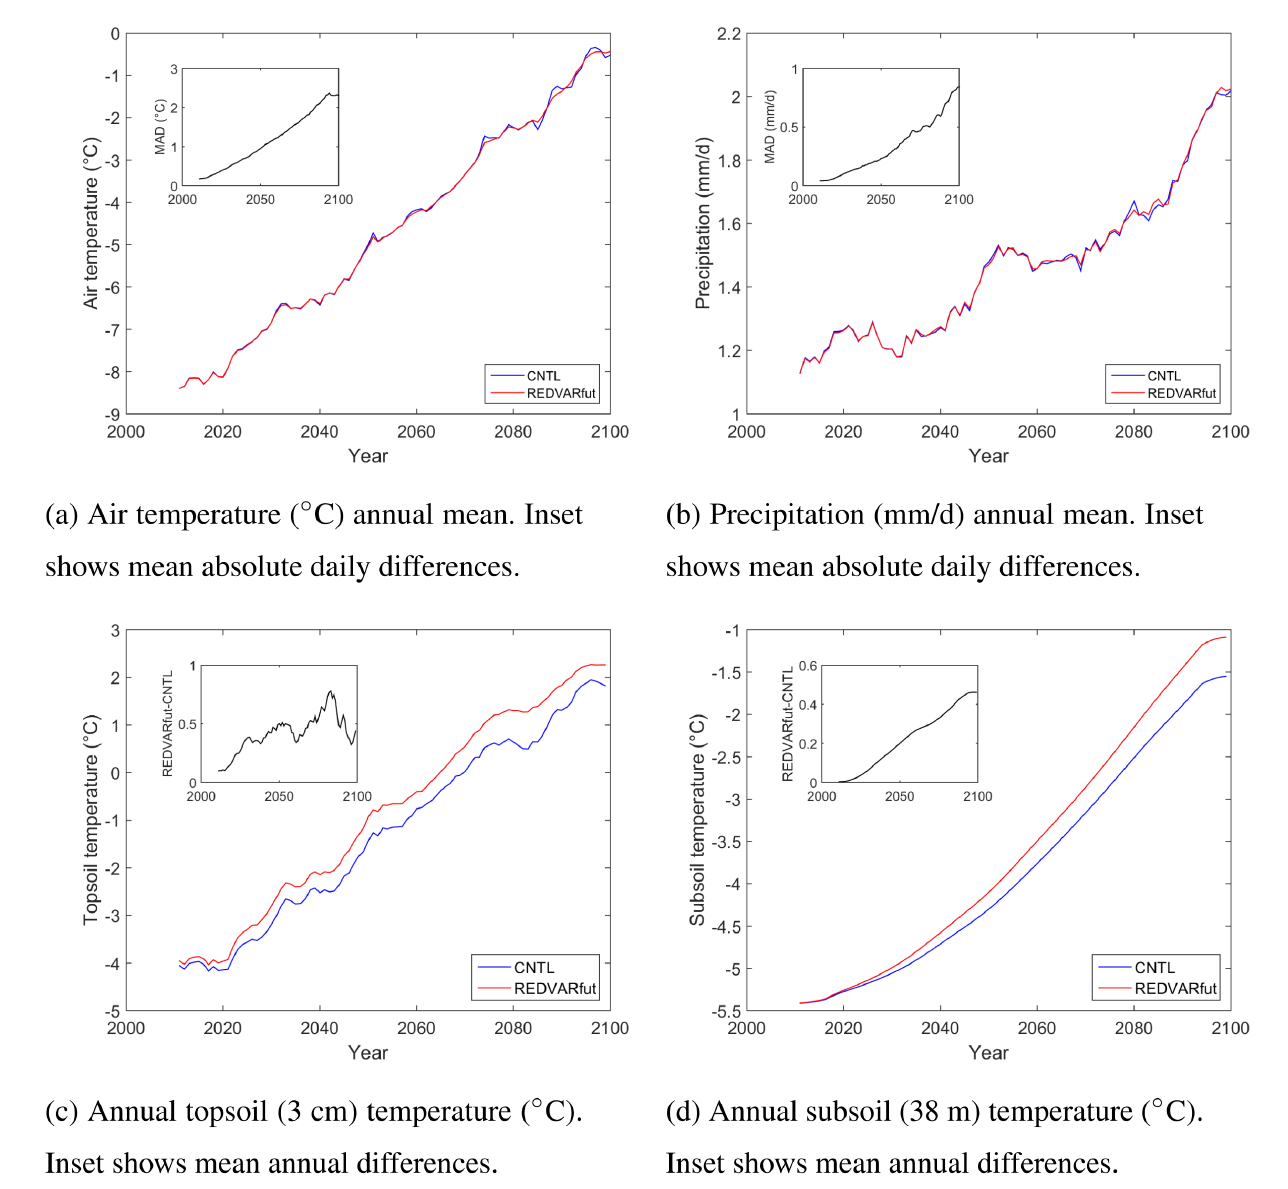
Figure 10. REDVARfut experiment results at a Canadian site (62.2 ◦ N, 75.6 ◦ E) during 2011–2100 showing the effects of changing climate variability on future soil temperature. Ten-year moving means are